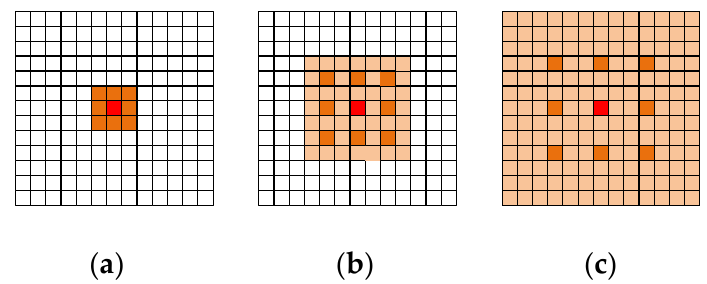
Figure 3. Dilated convolution with different dilation rates. ( a ) r = 1; ( b ) r = 2; ( c ) r = 3. Considering the grid effect, the design of the expansion rate in the DMLP model proposed in this paper follows Equation (7).